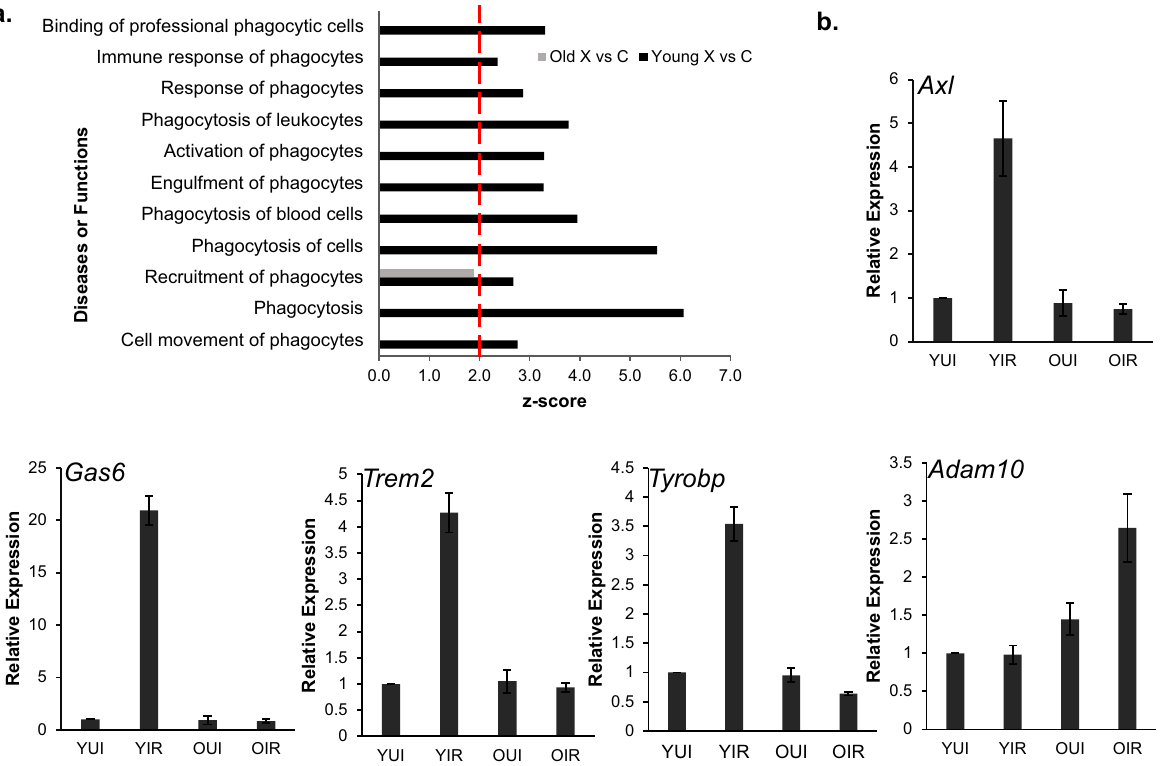
Figure 3. Phagocytosis-related biological functions are overrepresented in irradiated young male mice. ( a ) Significantly enriched phagocytosis-related functions in young-irradiated versus old-irradiated mice. X: x-ray; C: control (unirradiated). Dotted line marks z-score = 2.0. ( b ) Gene expression levels of 5 phagocytosis-related genes ( Axl , Gas6 , Trem2 , Tyrobp, and Adam10 ) analyzed by RT-qPCR and normalized to Actb expression. Data represent the mean ± S.E.M. (n = 3). YUI young unirradiated, YIR young irradiated, OUI old unirradiated, OIR old